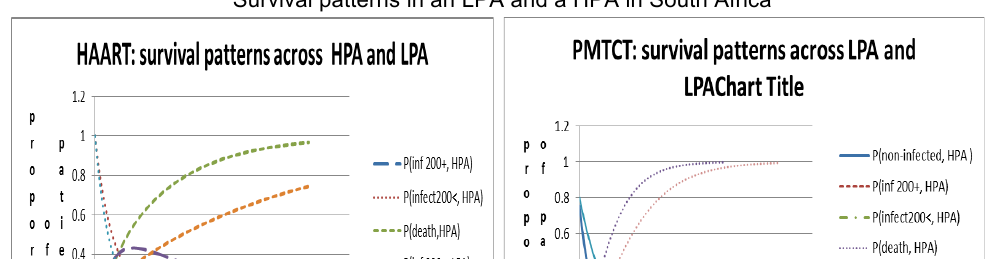
Survival patterns in an LPA and a HPA in South